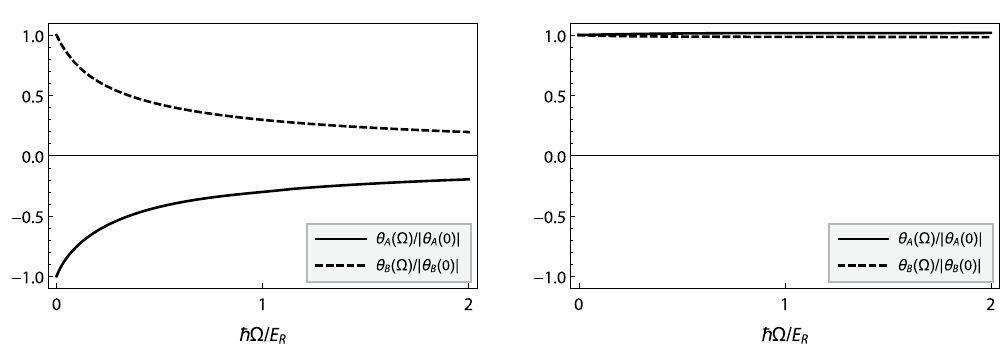
Figure 5. Effect of the Raman coupling on the real deformations: Depth of the real deformations θ j ( x = 0, Ω), in the position of the impurity, x = 0, as a function of the Raman coupling Ω for (left) = − = − g g g 10 AAab ( ) for (right) = = g g g 10 A B